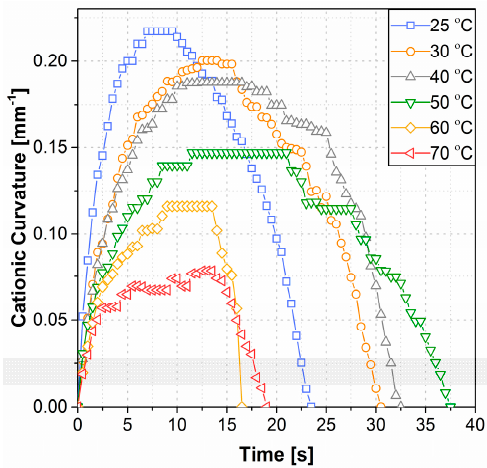
Figure 2. The cationic curvature at different temperatures.